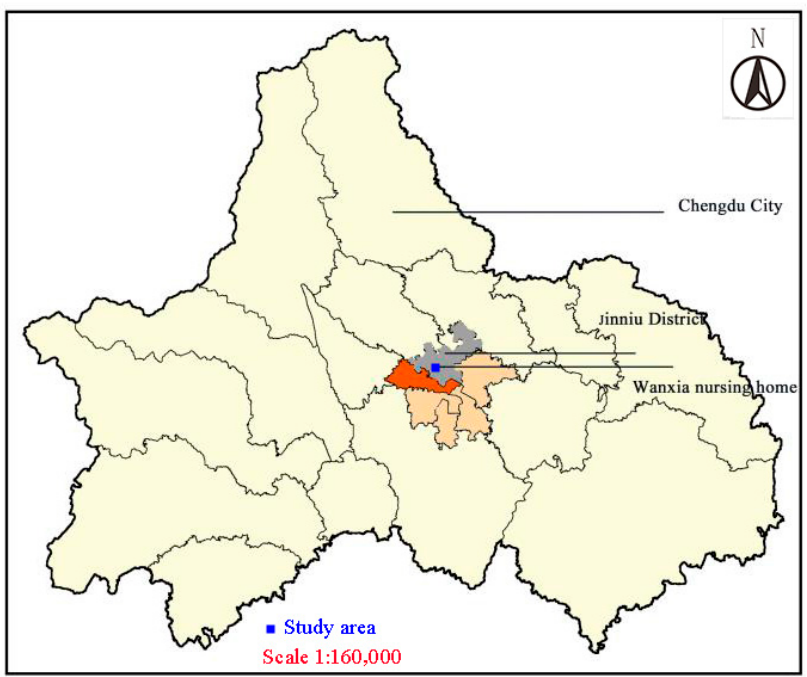
Figure 1. The location of the Wanxia nursing home, Chengdu City, China. Chengdu City is situated in the hot summer and cold winter zone of China. The mean air temperature (T a ) of the hottest month of July is about 2 ◦ C higher than that of other places with the same latitude across the world. The mean T a of the coldest month of January is about 8–10 ◦ C lower than that of other places with the same latitude across the world [33]. In 2020, the average daily T a in summer (from June to August) was 31 ◦ C, and the highest T a was 39 ◦ C. The average T a in winter was 11 ◦ C, and the lowest T a was 3 ◦ C [34]. Chengdu City belongs to a typical calm wind area. The annual mean wind speed (WS) is 0.7 m/s, and from 1980 to 2010, the frequency of calm weather in Chengdu City was approximately twice (24.06 days) that of other regions in China [35]. In addition,